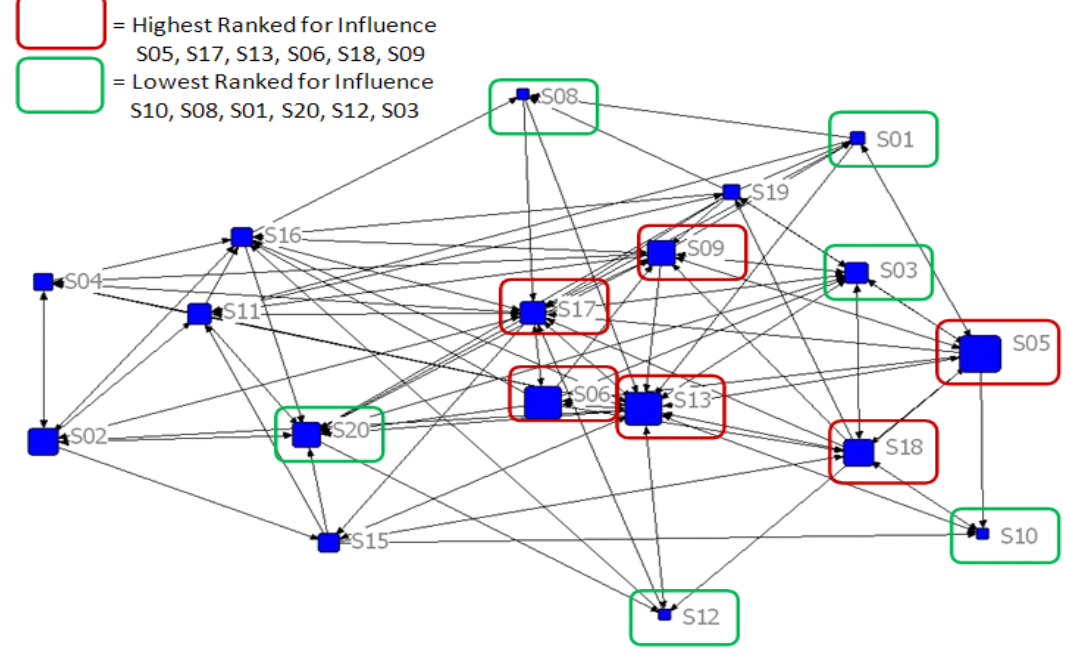
Figure 4 . Network graph: Module 6 discussions node size by combined discussion and journal LP and rankings for high vs. low influence (in-degree